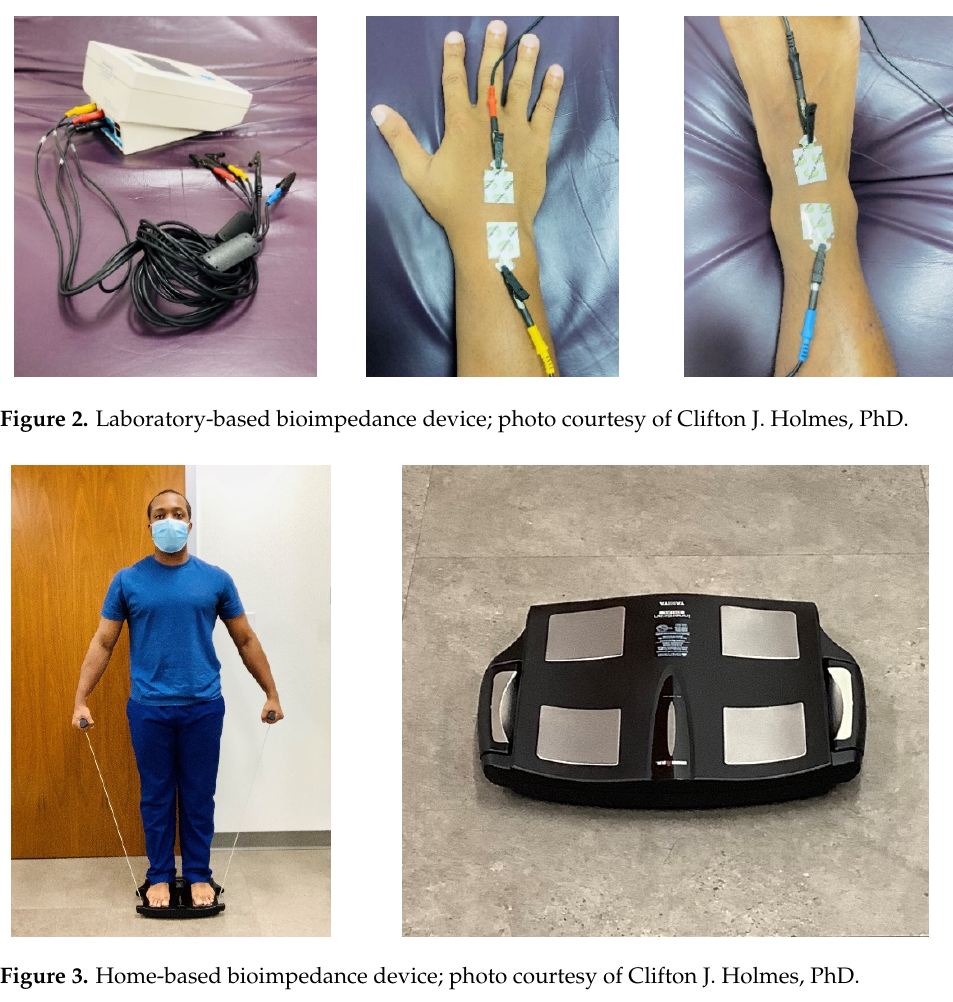
Figure 2. Laboratory-based bioimpedance device; photo courtesy of Clifton J. Holmes, PhD.